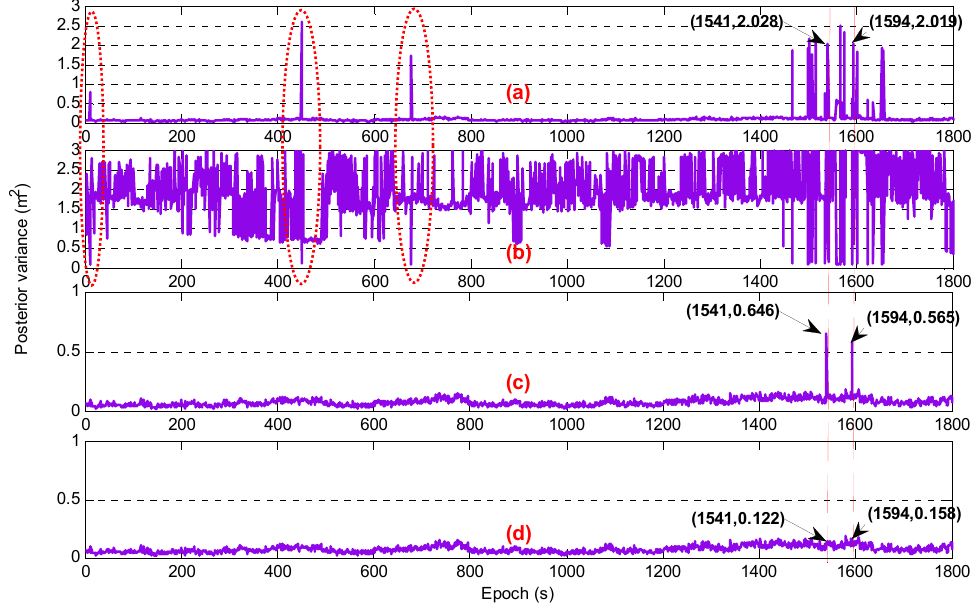
Figure 8. The performance of the posterior variance ( a ) with the initial ambiguity, ( b ) with candidate ambiguity during the first detection, ( c ) with the ambiguity after the first detection, and ( d ) with the final ambiguity.